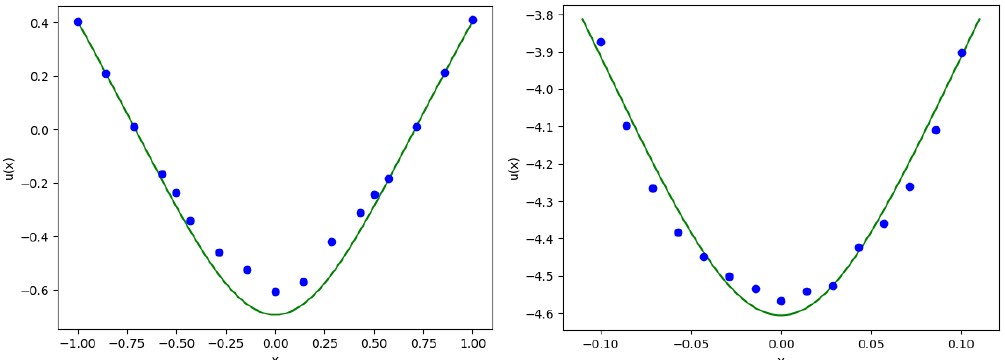
Figure 2. Approximate solution (blue) and reference solution (green) for the equation with quadratic gradient on the R 2 ( left ) and on the R 100 ( right